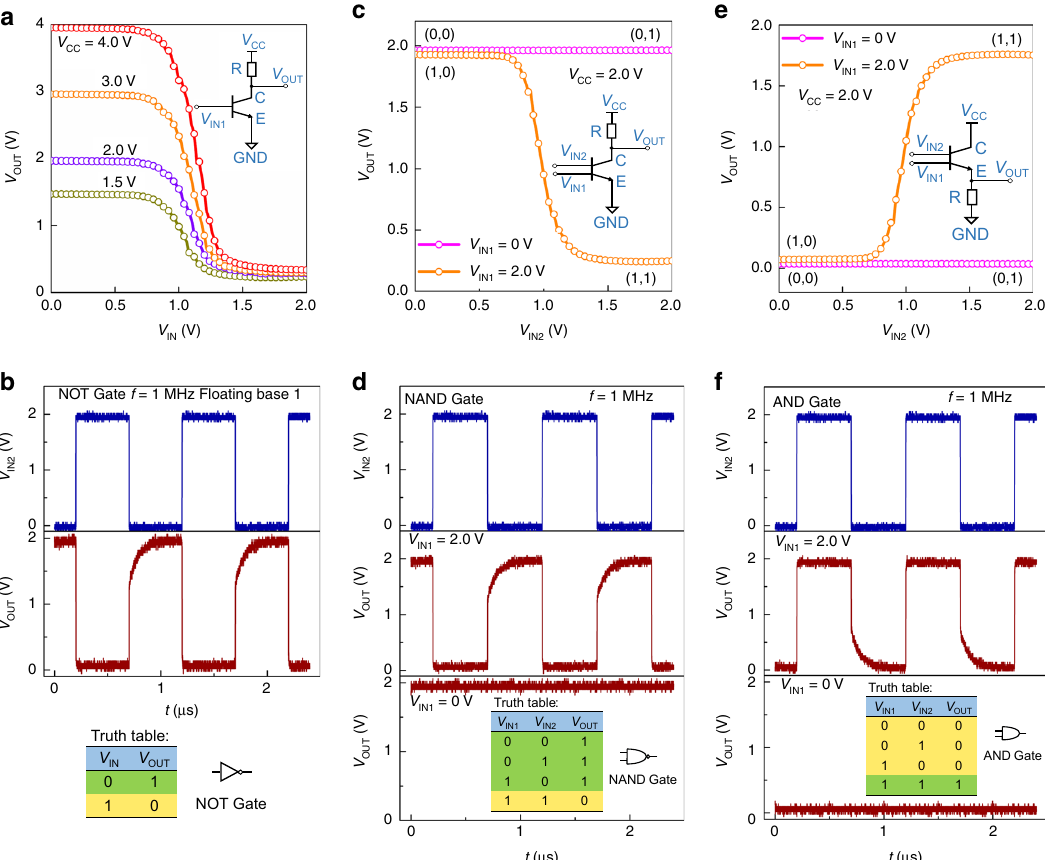
Fig. 5 Static and dynamic characteristics of logic circuits realized by OPDBTs. a , c , e Circuit diagrams and static voltage transfer characteristics of an inverter ( a ), a NAND gate logic circuit ( c ), and an AND gate logic circuit ( e ). b , d , f Dynamic characteristics and truth tables of the above corresponding logic circuits. The resistive load inverter is realized by an OPDBT and a 400 k Ω external resistor. GND represents the